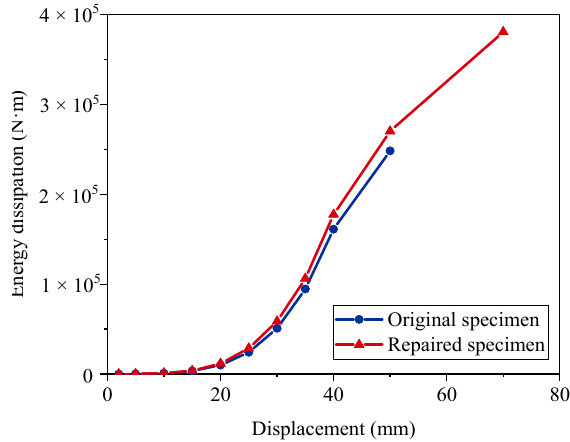
Figure 16. Cumulative energy dissipation. Strain gauges were instrumented on the surface of the CFRP fabrics to measure the strain of the column at different heights, as shown in Figure 6. The strain of the column surface at the heights of 100 mm, 200 mm, and 300 mm above the column–footing interface was recorded, as shown in Figure 17. The recorded data range was from displacement levels of 2 mm to 50 mm because they were complete cycles. The yield strain was calcu- lated as 1431.88 με . The surface concrete at the height of 100 mm and 200 mm reached the yield strain at the displacement level of 16.06 mm and 44.06 mm, respectively. The strain at the height of 300 mm did not reach the yield strain during the loading test. The curves of the strain were not strictly symmetrical. In particular, for the one at 100 mm above the column– footing interface, the minimal strain in the load cycles of 35 mm was at the displacement